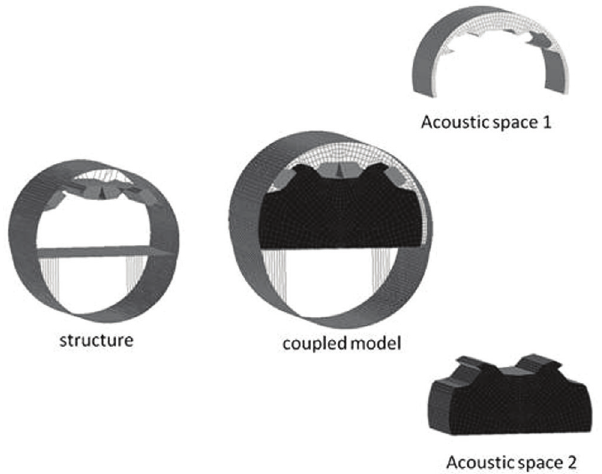
Fig. 1. Structural and acoustic portions of the